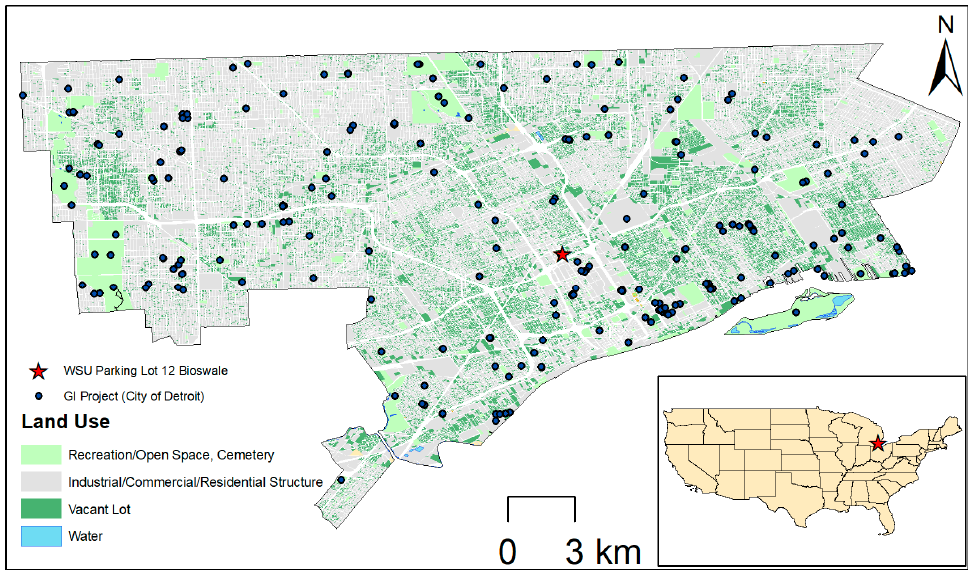
Figure 2. Geographic locations of the GI projects in Detroit, MI. Geographical locations of the GI Projects were downloaded from the City of Detroit Open Data Portal (https://data.detroitmi.gov/ (accessed on 23 August 2022)).